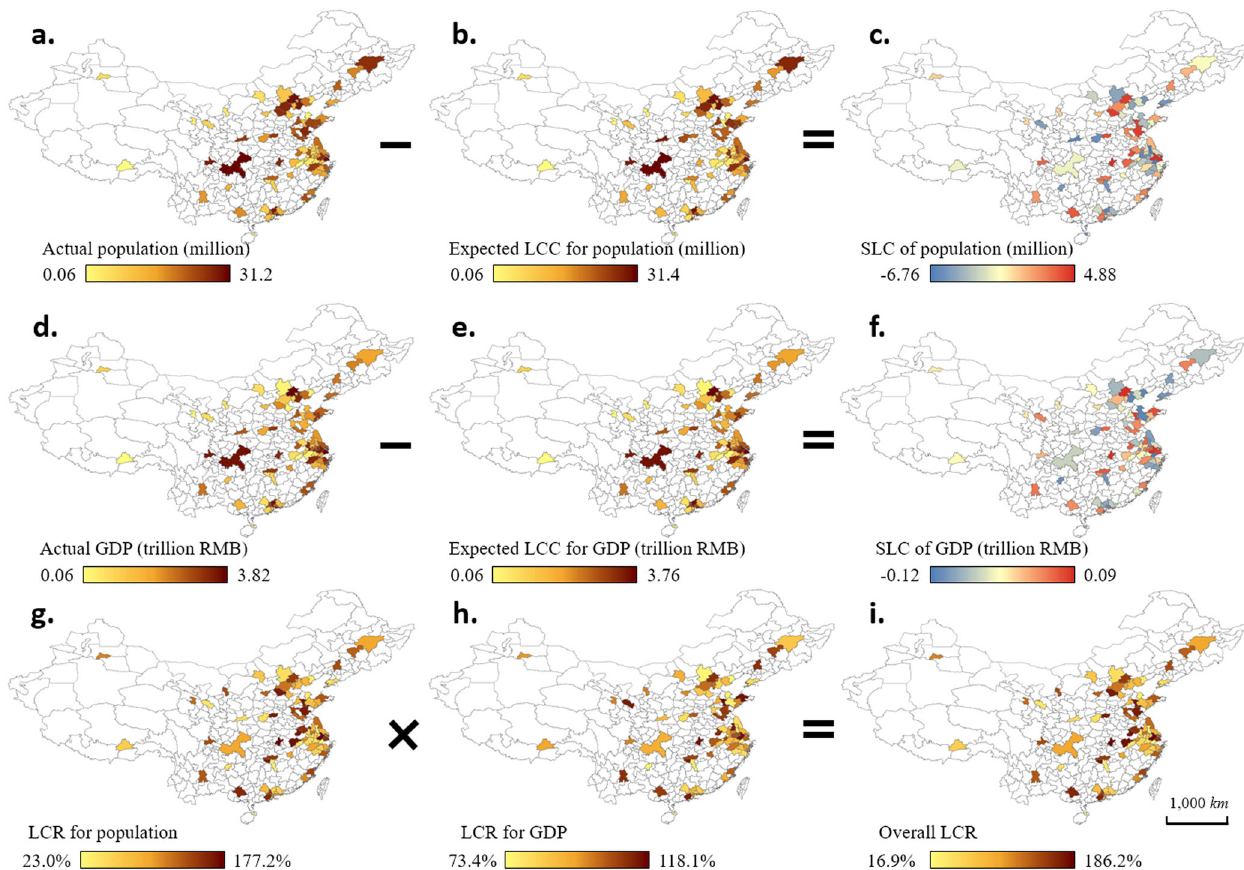
Fig. 3 Land carrying capacity (LCC), and the computations for shortage in land carrying (SLC) and land carrying rate (LCR) for 81 major cities. a – c the actual population of the cities, and their expected LCC for and SLC of populations. d – f the actual GDP of the cities, and their expected LCC for and SLC of GDP. g , h LCR for population and GDP of the cities. i overall LCR of the cities where dark brown represents the overload (high carrying rate), and light yellow the underload (low carrying